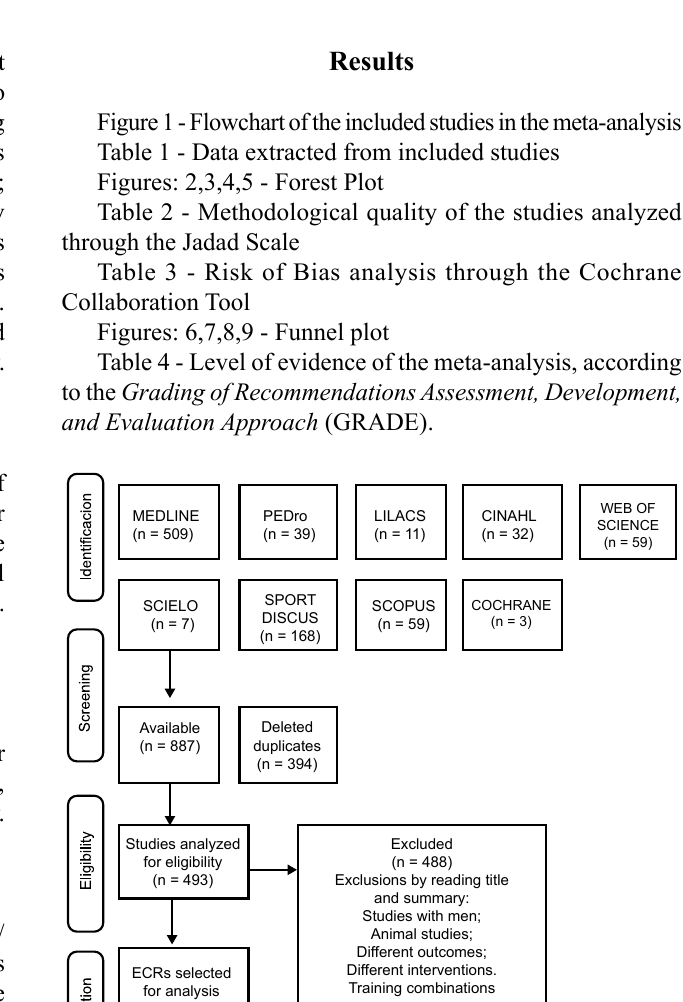
Figure 1. Flowchart of the selected studies for the